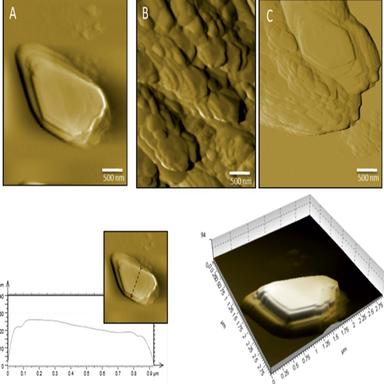
AFM images of VE3 (A), VE2 (B) and VE5 (C), together with the profile of sample VE3 showing the thickness of kaolinite layers with face-face contacts.